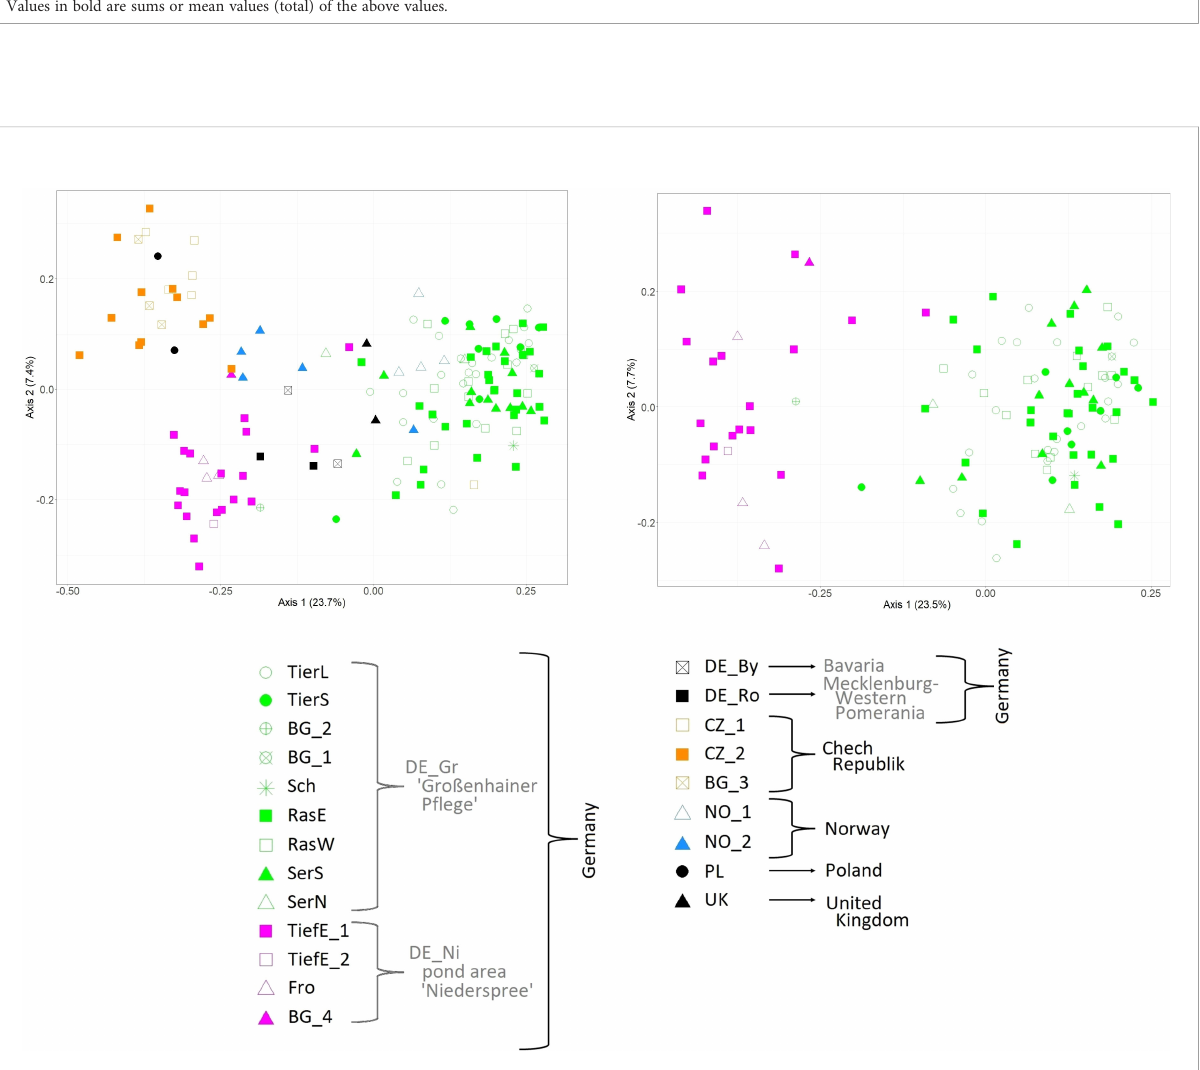
FIGURE 2 Principal Coordinate Analysis based on 48 AFLP loci of 151 individuals from European L. natans populations (left), and 113 individuals from Saxon populations only (right). Abbreviations for populations are according to Table